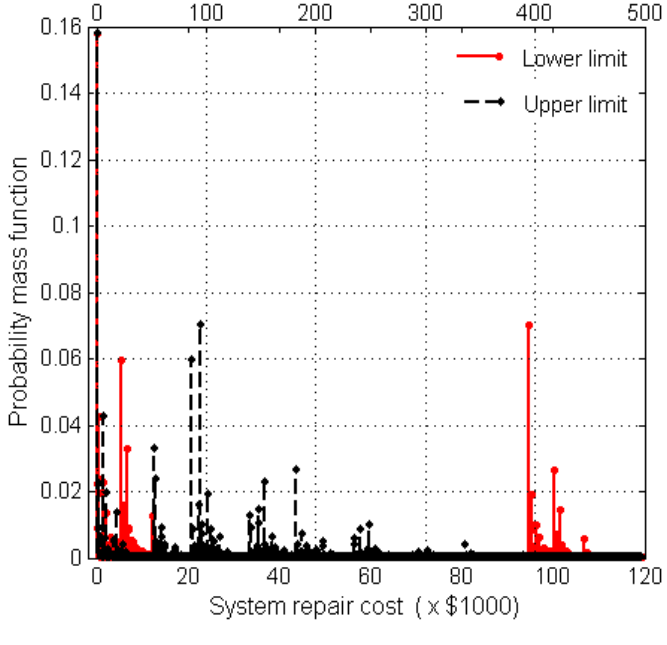
Figure 4. Probability distribution of repair cost for 12-subassembly wind